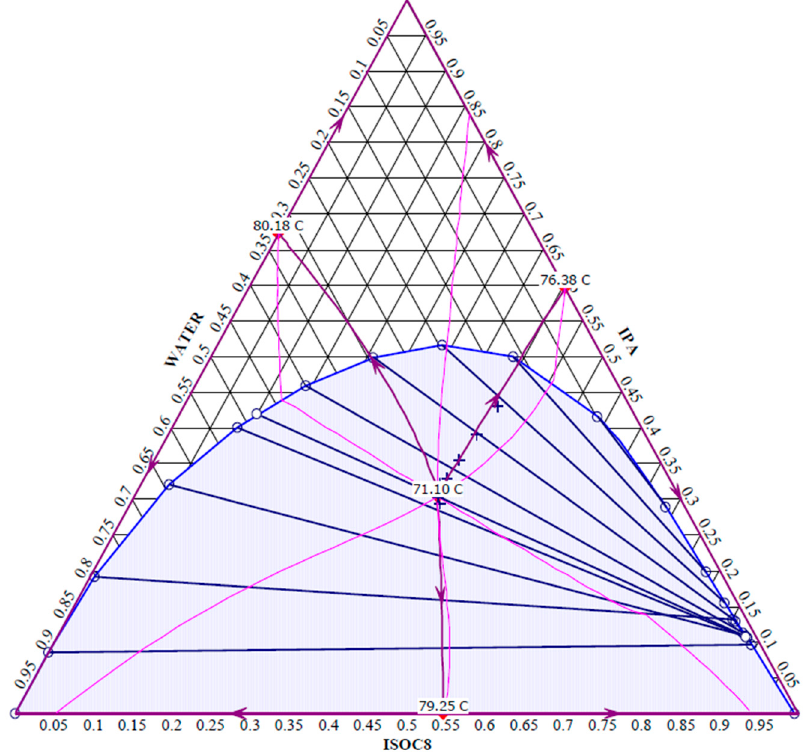
Figure 4. Ternary map at 1 atm, obtained by means of Aspen Plus ® V11 [61] using the NRTL model, for the system 2-propanol (IPA) + water (WATER) + isooctane (ISOC8).